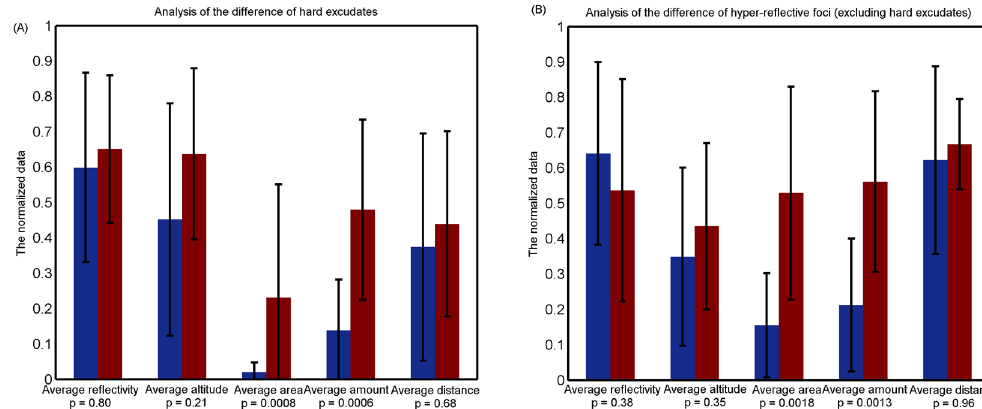
Figure 9. Results of analysis of the difference. ( A ) Results of the difference in hard exudates between NPDR and PDR in SD OCT. ( B ) Results of the difference in hyper-reflective foci (excluding hard exudates) between NPDR and PDR in SD